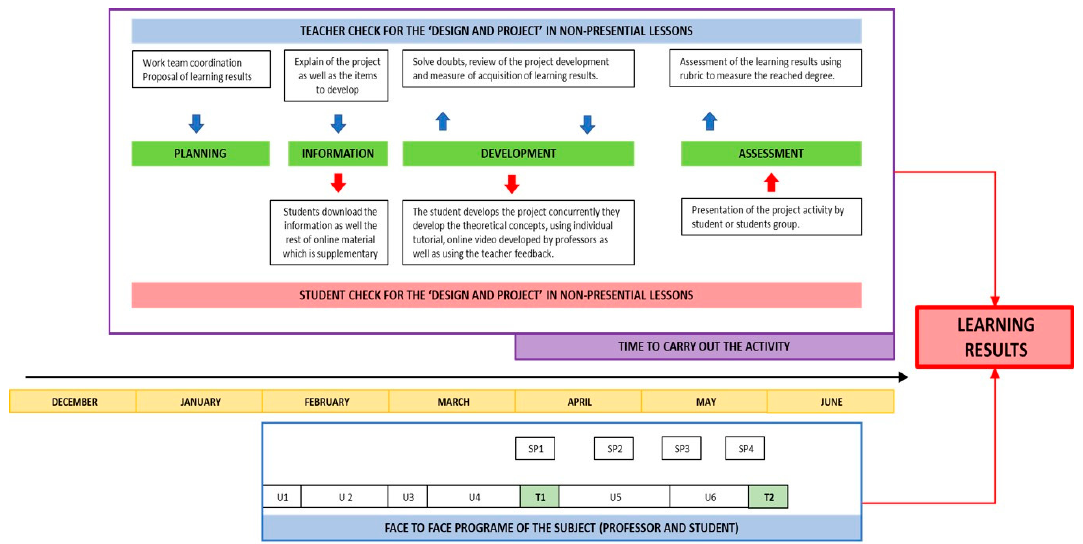
Figure 2. Example of temporal distribution to reach the learning results in a subject (U is unit, T is a test, and SP is simulation practice).